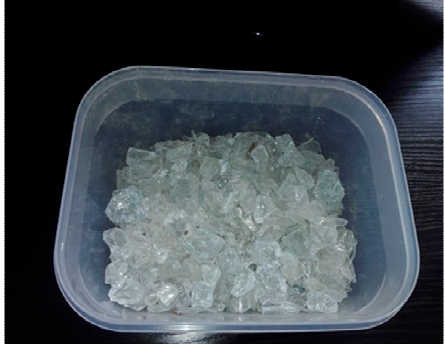
Figure 1. Glass cullet with a fraction of 0/16 mm. Table 1. Physical and chemical properties of TERMISIL borosilicate glass.